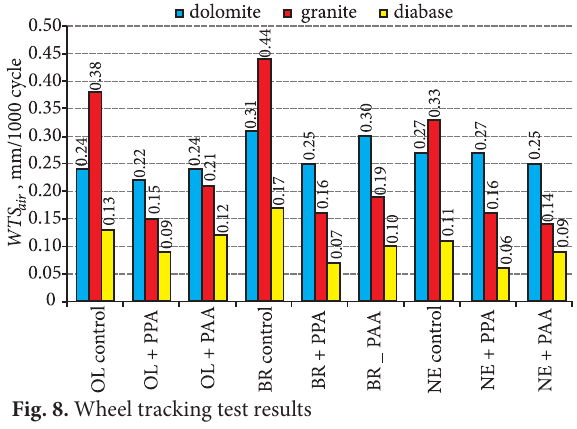
Fig. 8. Wheel tracking test results